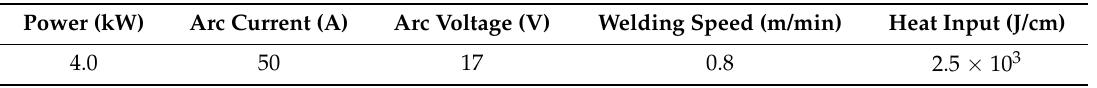
Table 4. Cosmetic weld parameters (thermal efficiency = 0.7).